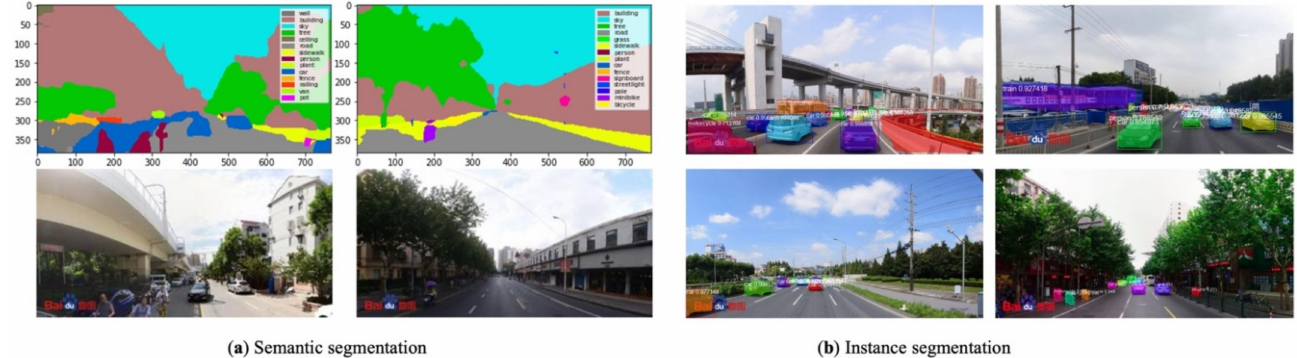
Figure 4. CV Segmentation results. ( a ) Pairwise PSPNet semantic segmentation results with its raw input. ( b ) Mask R-CNN instance segmentation results counting